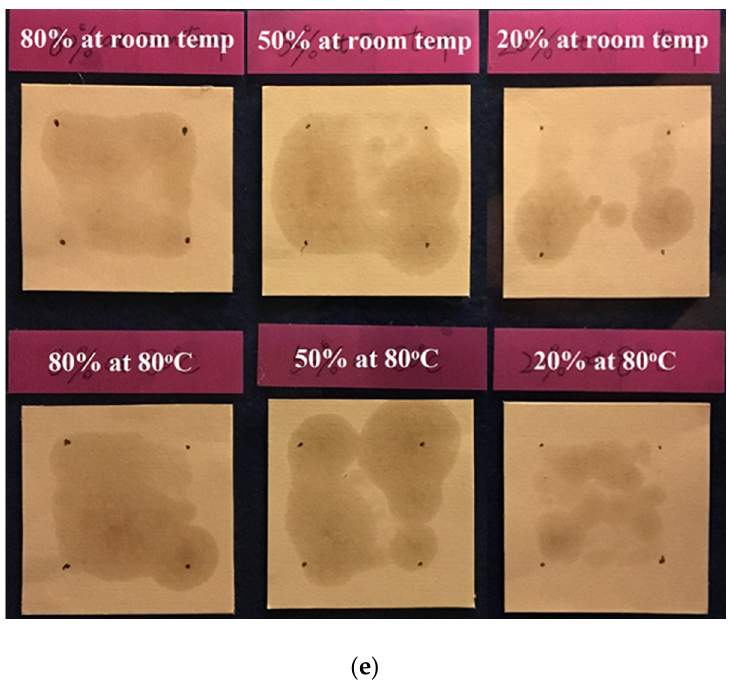
Figure 11. Oil-dripping experiments in foam samples after shape recovery from programming at room temperature (80 ° C) to ε m of 20%, 50% and 80%. ( a 1 ) Samples upon dripping; ( a 2 ) side view upon dripping; ( b – e ) top views of the papers underneath after 4, 8, 14, and 24 h upon dripping, respectively. Red circles in ( a ) and ( a 1 ) indicate the oil drops.